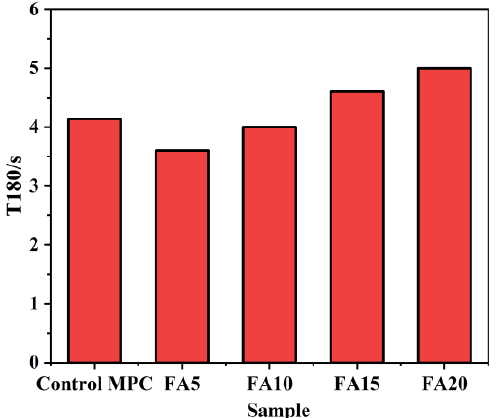
Figure 6. The effect of FA content on MPC T180 value.